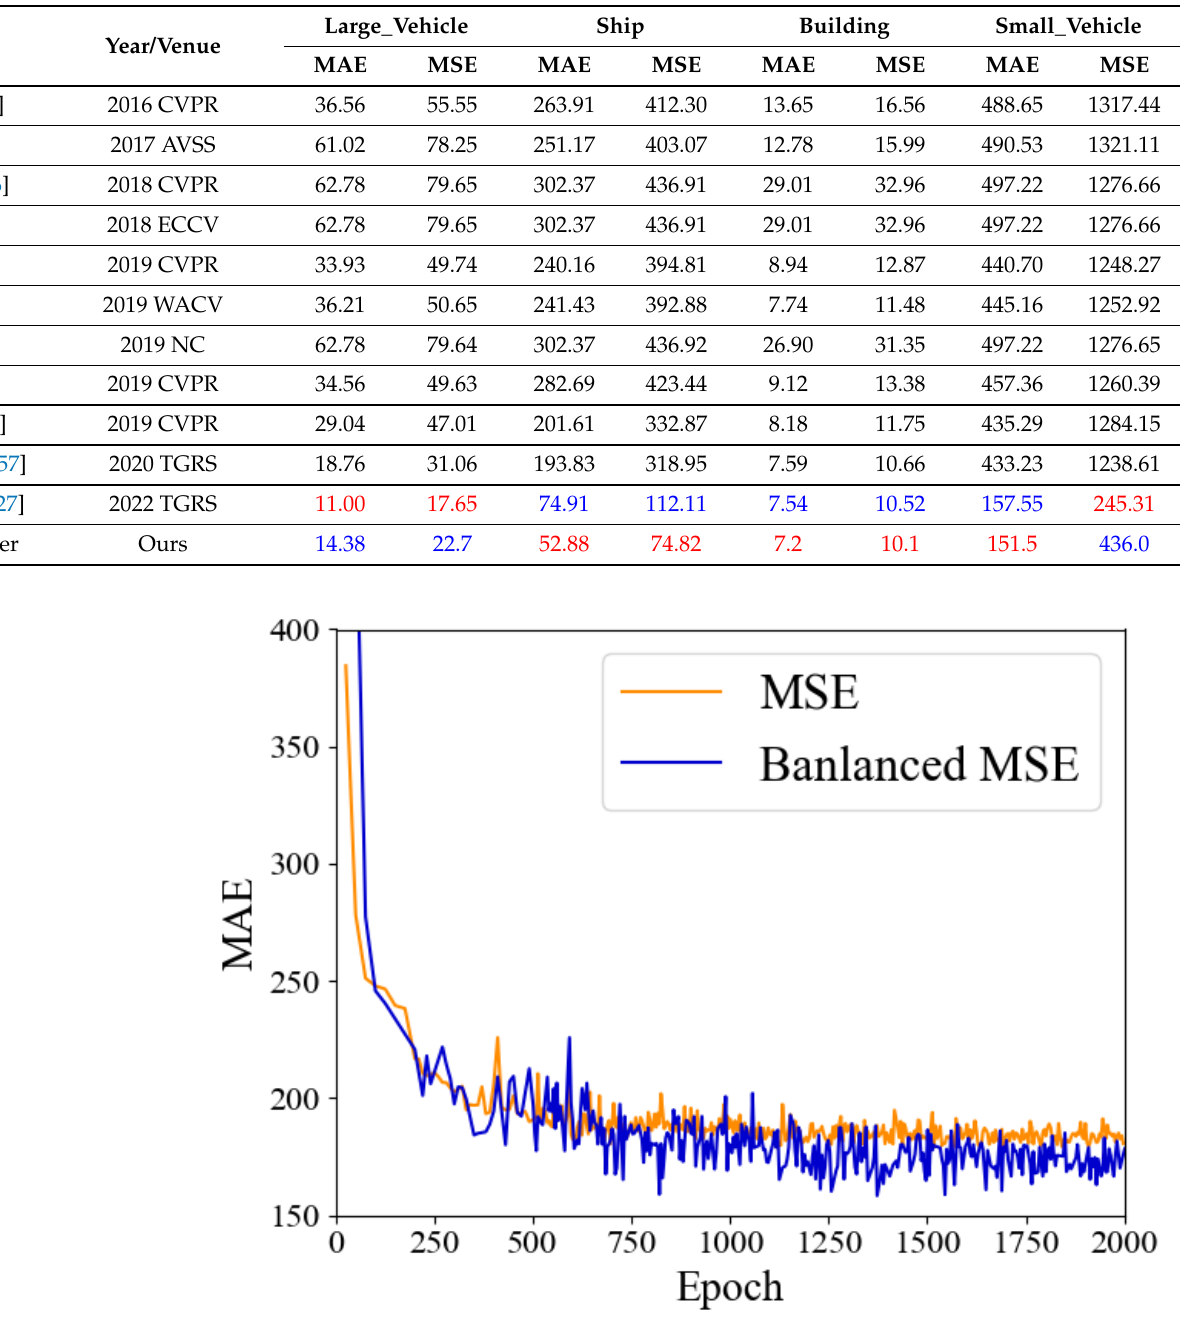
Figure 7. The MAE convergence curve during the training process on the RSOC Small-vehicle dataset under the MSE and Balanced MSE loss function. the orange one is the curve under MSE loss, and the blue one represents Balanced MSE